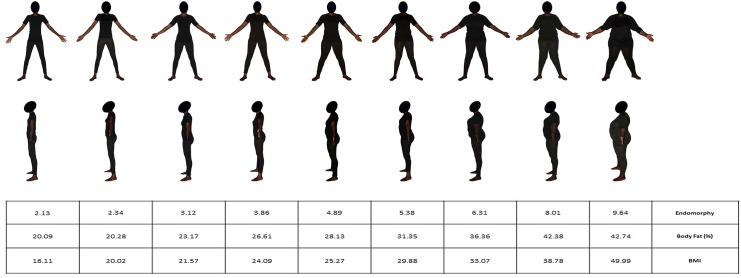
Female Body Size Scale.The scale shows 9 Black female models from front and left side-views, and ordered by increasing adiposity. The table gives the levels of endomorphy component, body fat percentage and body mass index corresponding to each model.